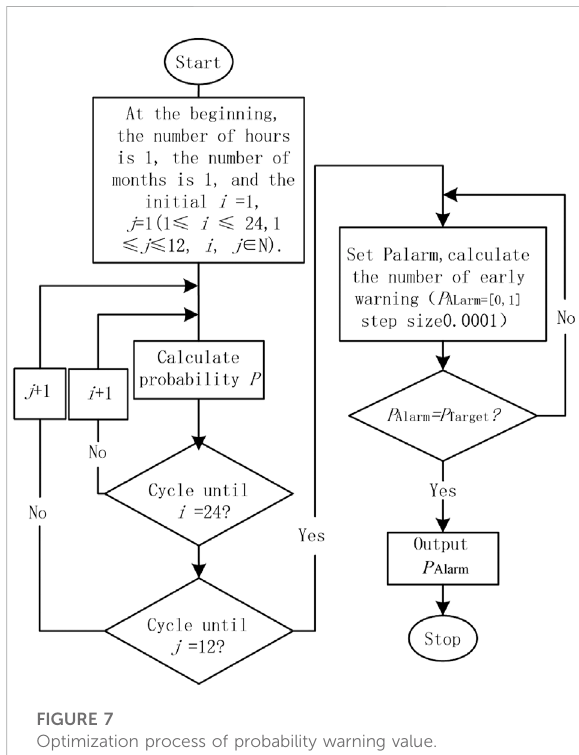
FIGURE 7 Optimization process of probability warning